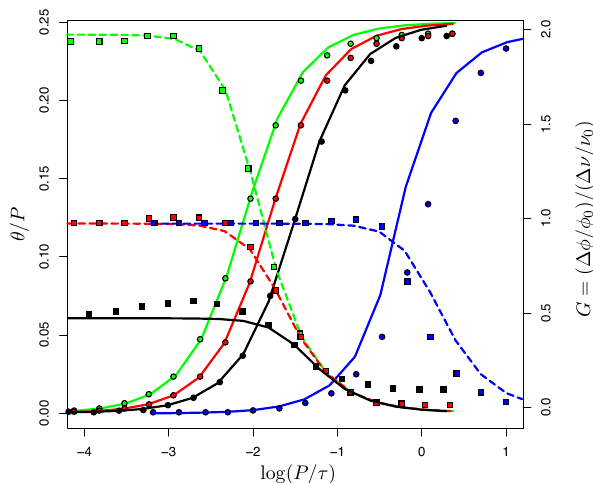
Figure 1. Predictions of the quasi-analytical solution (solid and dashed lines) and the numerical simulation (squares and circles). The solid lines and circles represent the time lag (divided by the forcing period, P ) and the dashed lines and squares represent the gain, both as a function of the forcing period, P (normalized by the characteristic time of the system, τ ). The green, red and blue lines/symbols correspond to values of ( m , n ) equal to (0.5, 1) and (1, 2) and (2, 4), respectively, such that m/n = 1 / 2 in all three cases. The blue lines/symbols correspond to the case where ( m , n ) = (1, 3), i.e., m/n = 1 / 3 (cid:54)= 1 / 2, which explains why, in that case, the quasi- analytical solution is less